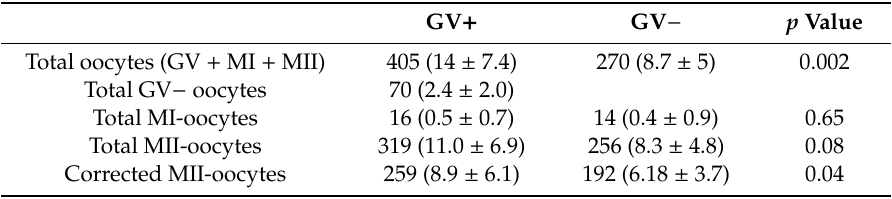
Table 3. Oocyte numbers and maturation